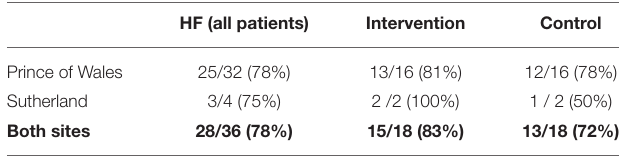
TABLE 2 | Cardiac rehabilitation attendance rate and completion rate. Parameter